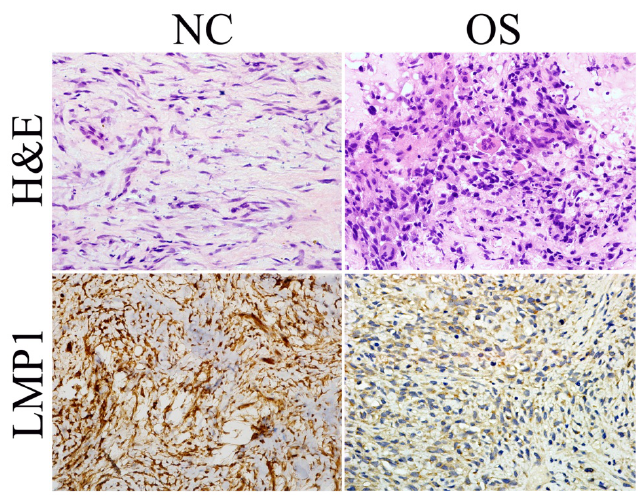
Figure 1. Dysregulated LMP-1 expression in osteosarcoma (OS) tissues. Representative immunohistochemical images showing LMP-1 expression in primary OS and adjacent normal tissues. Positive cells were scattered throughout the matched normal tissues ( left panel ); 31 out of 43 total OS specimens showed suppressed levels of the LMP-1 protein (scores 0 and 1+, right panel ). HE, hematoxylin and eosin